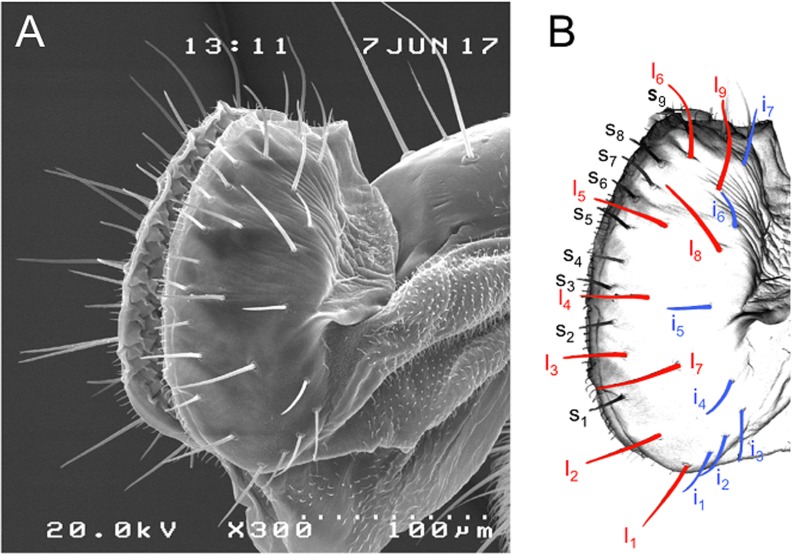
(A) SEM image of a proboscis hemilabellum of Drosophila suzukii showing the distribution pattern of taste sensilla. (B) Corresponding schematic arrangement of the three sensillum types: small (s1-9), intermediate (i1-7) and large (l1-9).